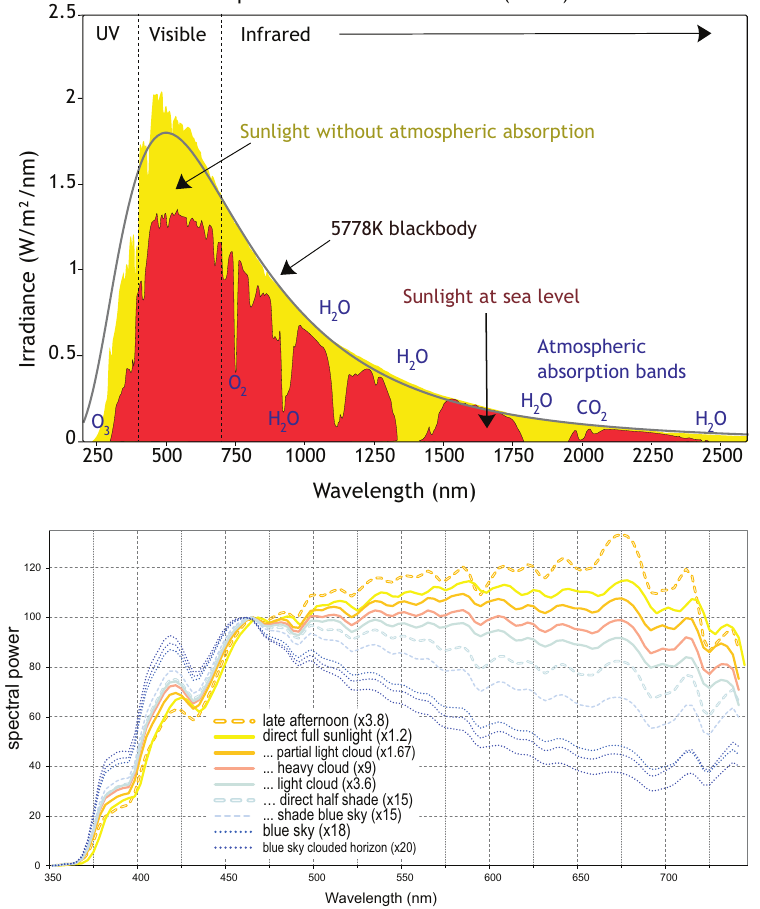
Figure 4. Sun-light spectrum at sea level versus the full radiation above the atmosphere (upper panel). Figure 4. Sunlight spectrum at sea level versus the full radiation above the atmosphere ( upper panel). Dispersion proportion for additional damping of sun-light by atmospheric illumination conditions Proportion of dispersion for additional damping of sunlight by atmospheric illumination conditions (lower panel). ( lower panel). Table 1. Bandgaps in mixed-halide perovskites with large and small gaps (MA—CH 3 NH + lammonium)